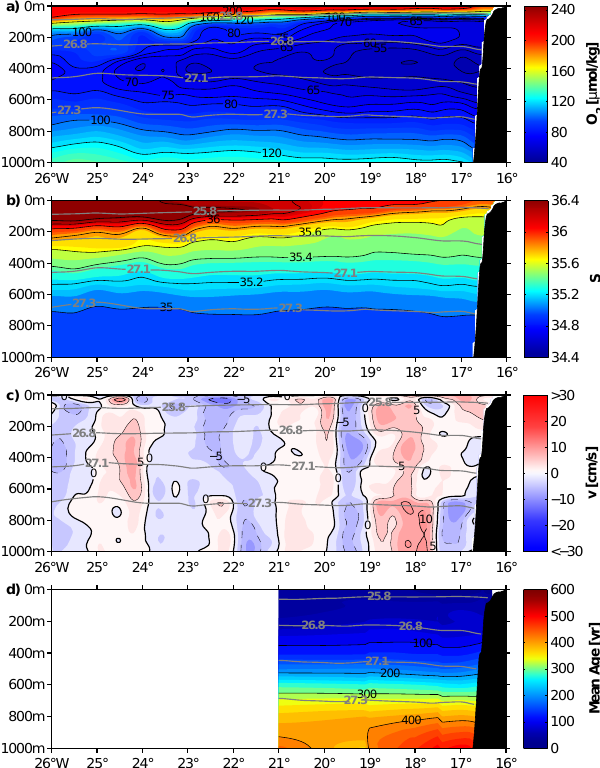
Figure 5. (a) Mean oxygen content, (b) salinity, (c) meridional velocity (positive northward), and (d) mean age as obtained from zonal ship sections taken along 18 ◦ N from 2005 to 2012. Grey contours mark potential density (kgm − 3 ). Besides the deep oxy- gen minimum at about 400m in depth, there is a shallow oxygen minimum at about 100m in proximity to the shelf (a)